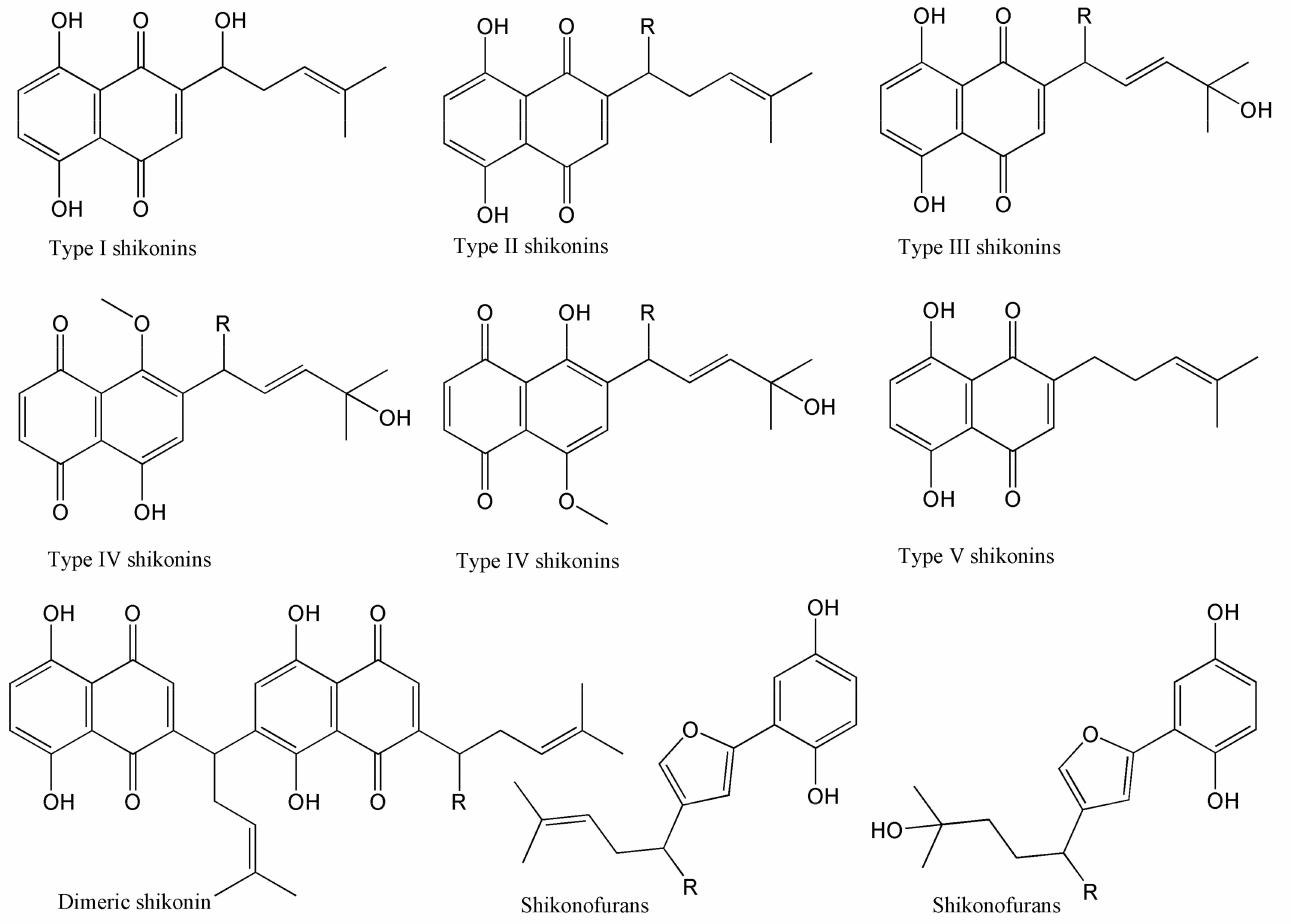
Figure 3. Chemical structures of 7 different types of shikonin compounds found in Arnebiae Radix